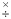
Relative error of the temperature-dependent and temperature-independent functions when used to predict size-class biomasses for independent, unassimilated observations.Dots represent the mean temperature and geometric mean relative error for each data subset, with error bars showing ±1 standard deviation for temperature, and ÷×1 geometric standard deviation for the relative error.